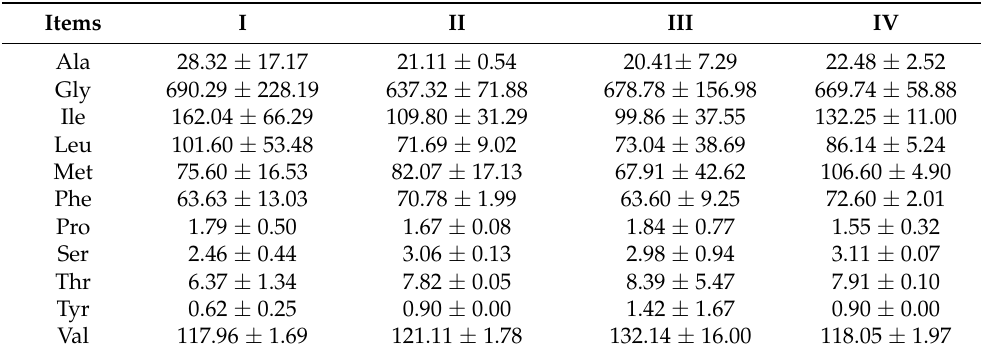
Table 9. Effects of dietary supplementation with different inclusion of SMS-MP on plasma amino acid of growing sika deer ( µ